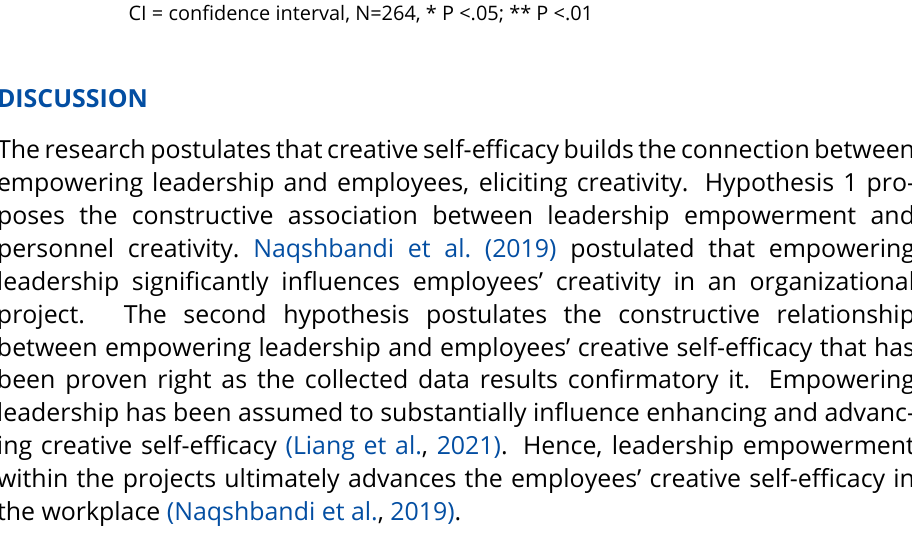
Table 6. Moderating effect of project culture Int-term ! Employee